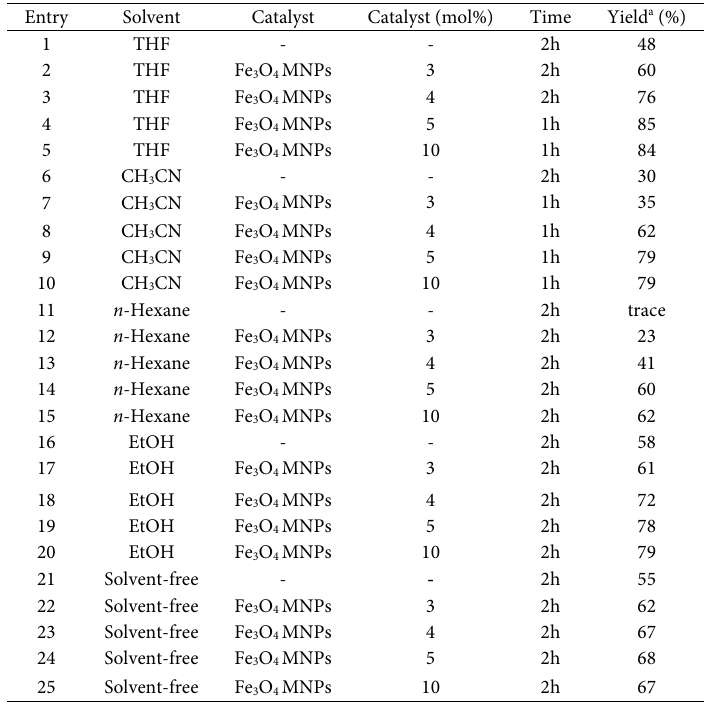
Table 1 : Reaction of isatin (1mmol) and o -phenylenediamine (1 mmol) under different conditions Table 1: Reaction of isatin (1mmol) and o -phenylenediamine (1 mmol) under different